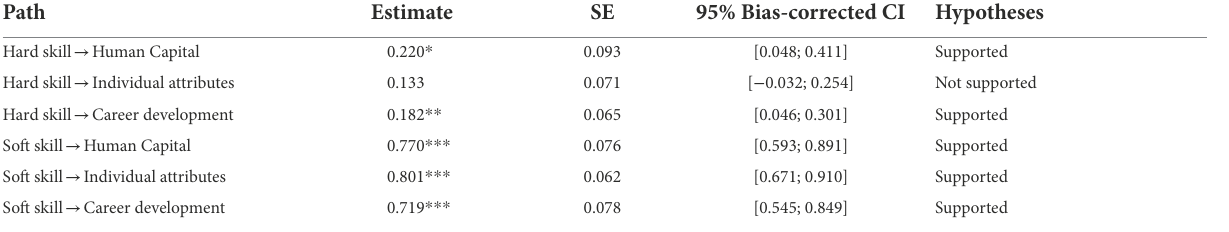
TABLE 5 SEM results including coefficients.